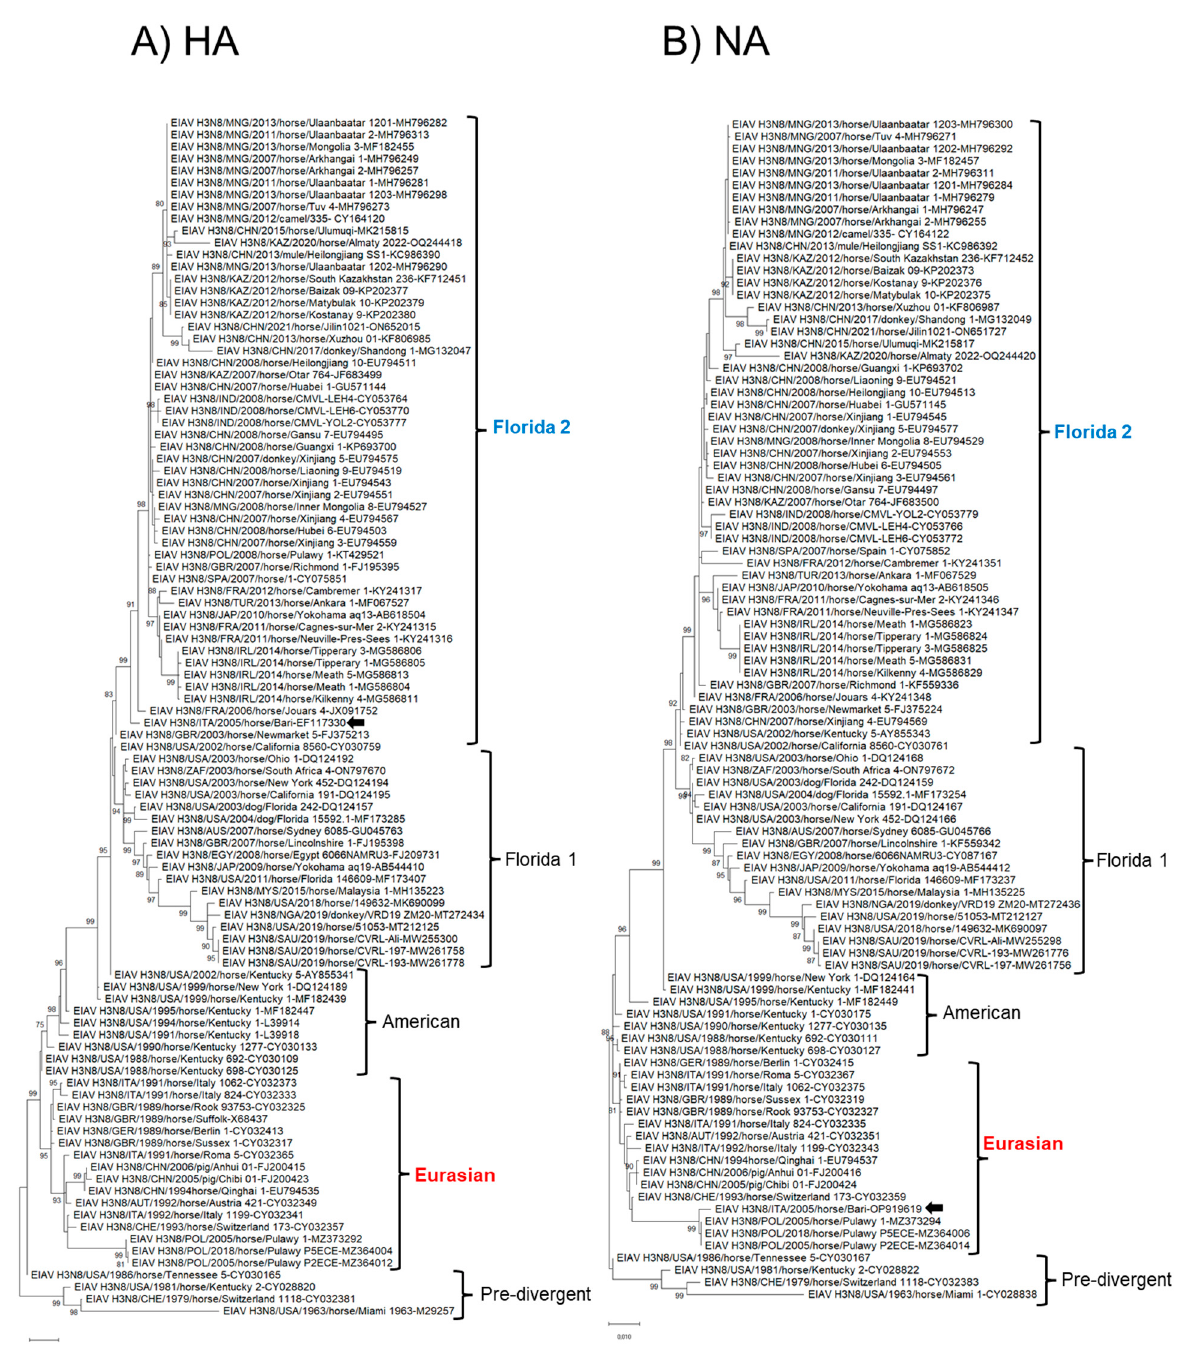
Figure 2. Phylogenetic analysis of haemagglutinin and neuraminidase genes of EIAV subtype H3N8 strain ITA/2005/horse/Bari compared with cognate sequences retrieved from GenBank database. Phylogeny of the hemagglutinin (HA) gene ( A ). Phylogeny of the neuraminidase (NA) ( B ). Phylogenetic trees were performed using the maximum likelihood method and Hasegawa–Kishino–Yano 2-parameter model with a gamma distribution. A total of 1000 bootstrap replicates were used to estimate the robustness of the individual nodes on the phylogenetic tree. Bootstrap values greater than 75% were indicated. Black arrow indicates the strain described in this study. Numbers of nucleotide substitutions are indicated by the scale bar .